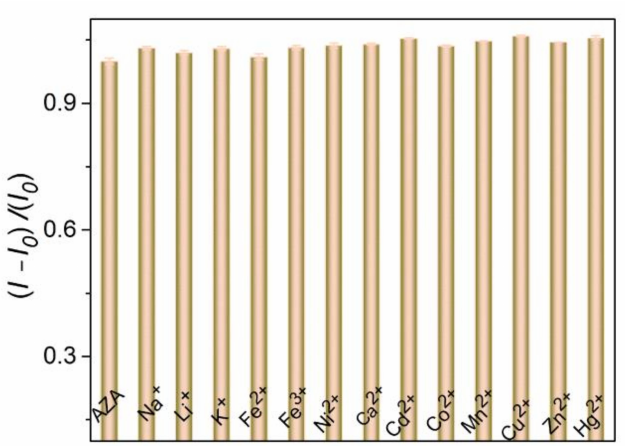
Figure 8. Selectivity toward other interfering species. I 0 denotes the ECL emission of 0.5 mM Ru(bpy) 32+ with 2 µ M AZA and I denotes the ECL signal after introduction of the interfering species; ( I − I 0 )/ I 0 denotes the ECL change after introducing the interfering components. The concentration of the interfering species was 20 µ M; 0.1 M PBS; pH 8.5.